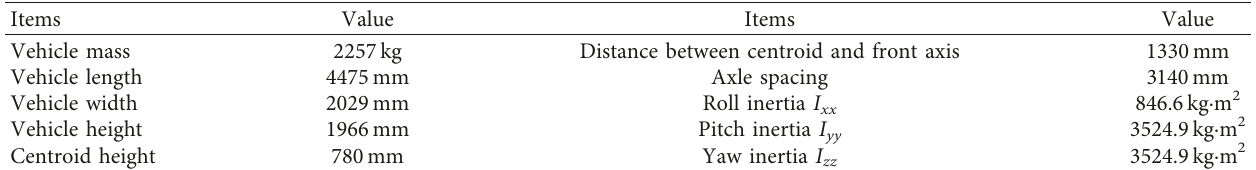
Table 2: Parameters setting of vehicle